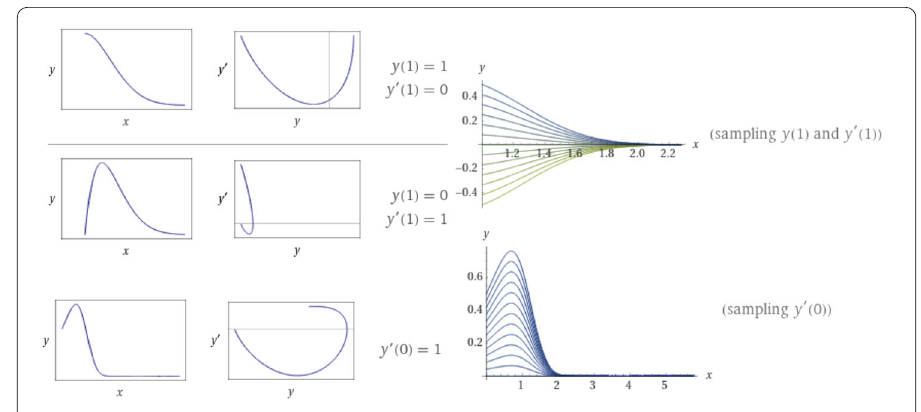
Figure 2 The solution of (3.10) for ℘ =